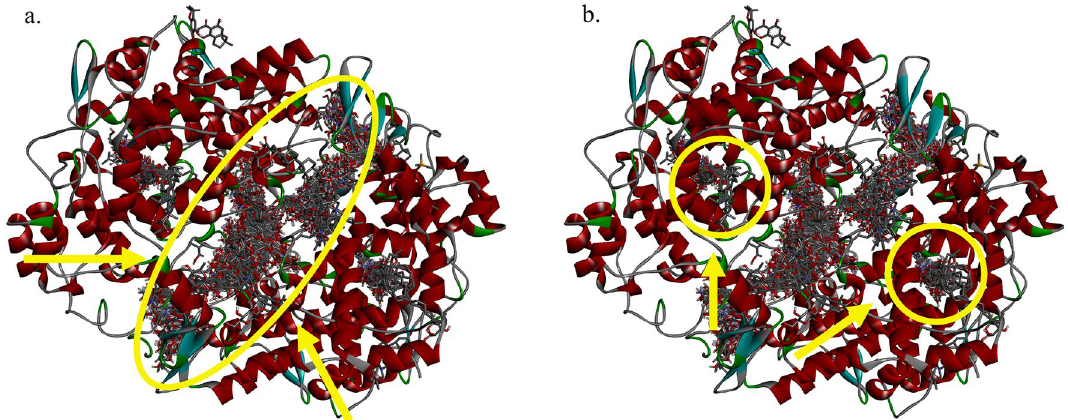
Figure 3. Docking pose interactions between all compounds and prostaglandin-endoperoxide synthase 2 (T03). ( a ) Primary binding sites of prostaglandin-endoperoxide synthase 2. ( b ) Active binding sites of prostaglandin-endoperoxide synthase